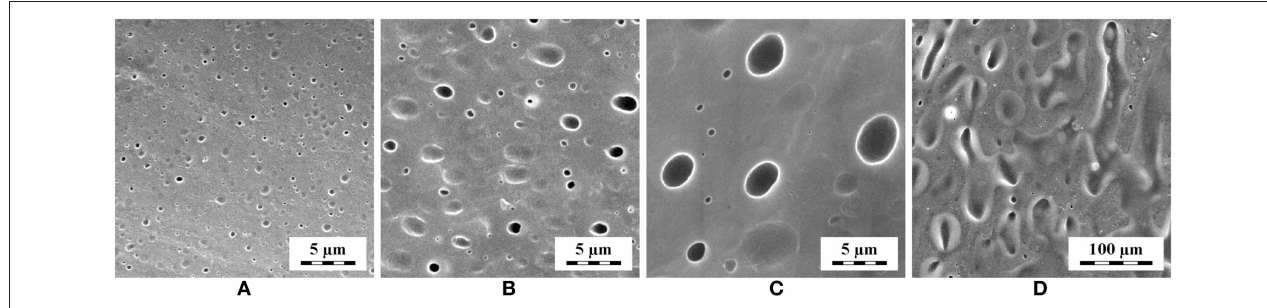
FIGURE 2 | SEM micrographs showing morphology of compression molded PLA/PCL blends with composition (wt.%/wt%): (A) 90/10, (B) 80/20, (C) 70/30, and (D) 60/40. The samples were smoothed and PCL was etched off as described in Ostafinska et al. (2015). Note the scale change in the last micrograph with coarse continuous morphology of PCL phase.